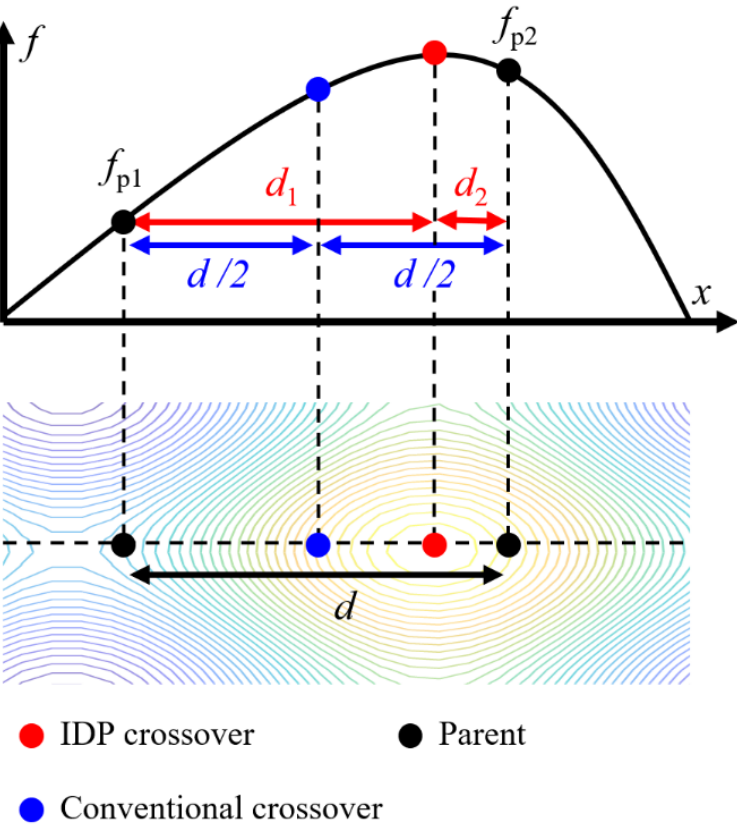
Figure 1. Comparison of conventional crossover and IDP crossover.